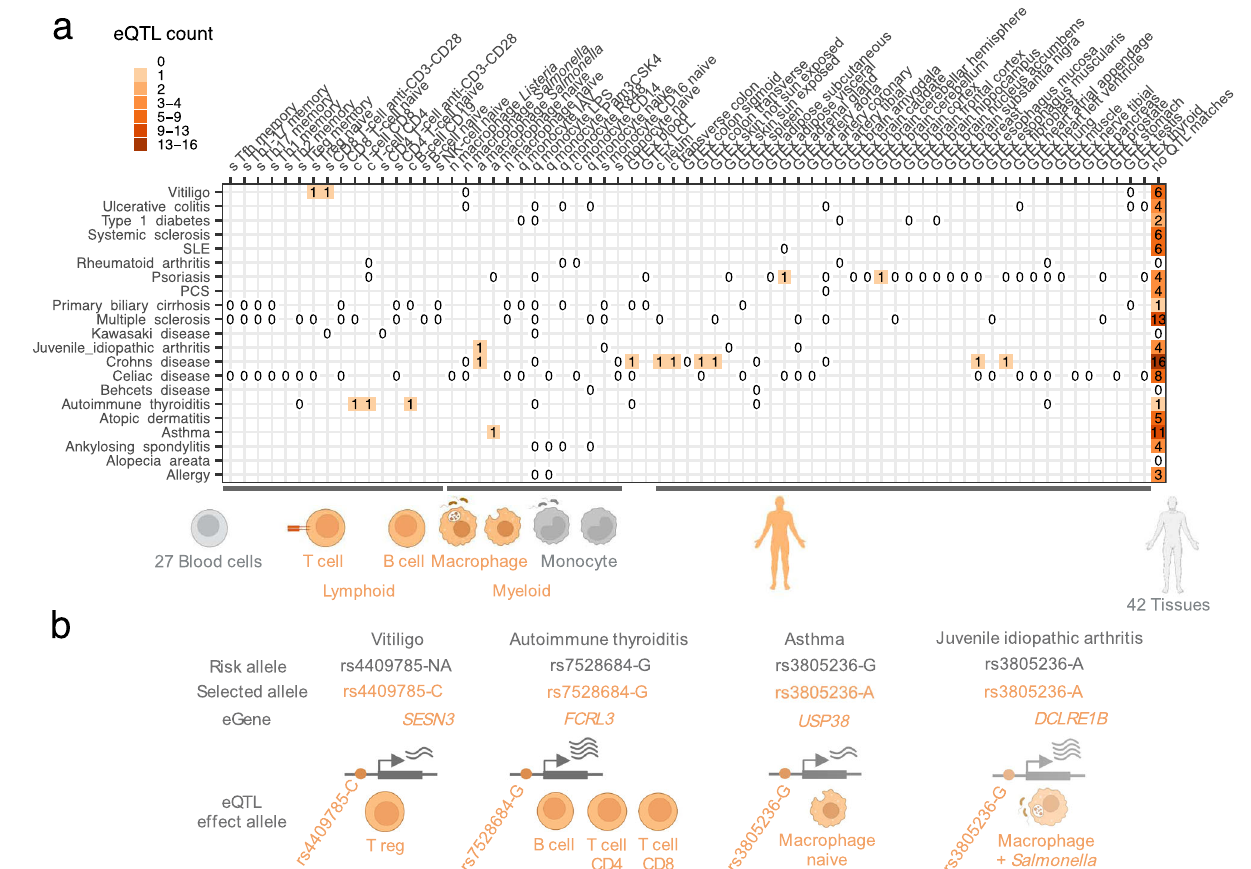
Fig. 4 | In fl ammatory diseases and candidate SNPs under selection. a Heatmap shows the number of selection targets for each disease (disease eQTLs) among candidate SNPs annotated with eQTL. To provide background, we use ‘ 0 ’ to show disease eQTLs that are not under selection. Tissue/cell context for each eQTL is given in columns and highlighted schematically below the heatmap. Full